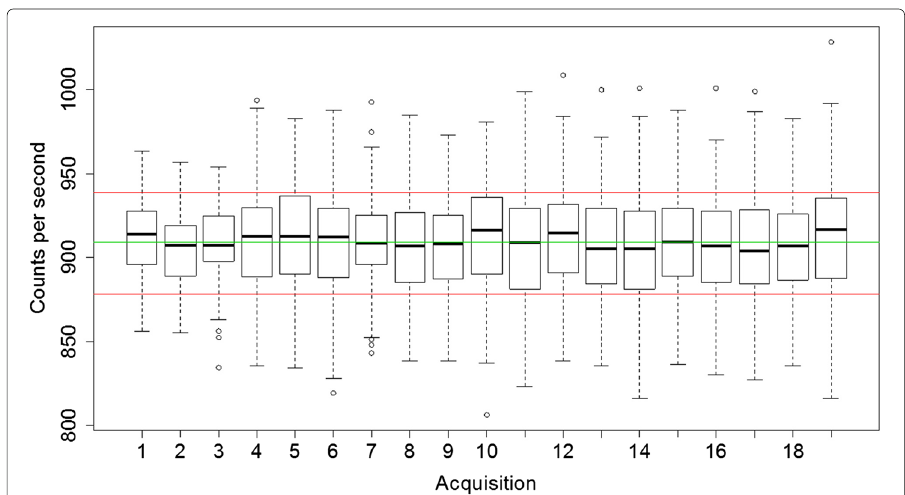
Fig. 10 Box-and-whisker plot representation of nineteen 3-min measurements over 3 weeks, showing median values, upper and lower quartile values ( boxes ), minimum and maximum values excluding outliers ( whiskers ) and outliers (1.5 times the upper/lower quartiles shown as points). The greenline represents the mean value of all data, while the redline represents one standard deviation from the mean